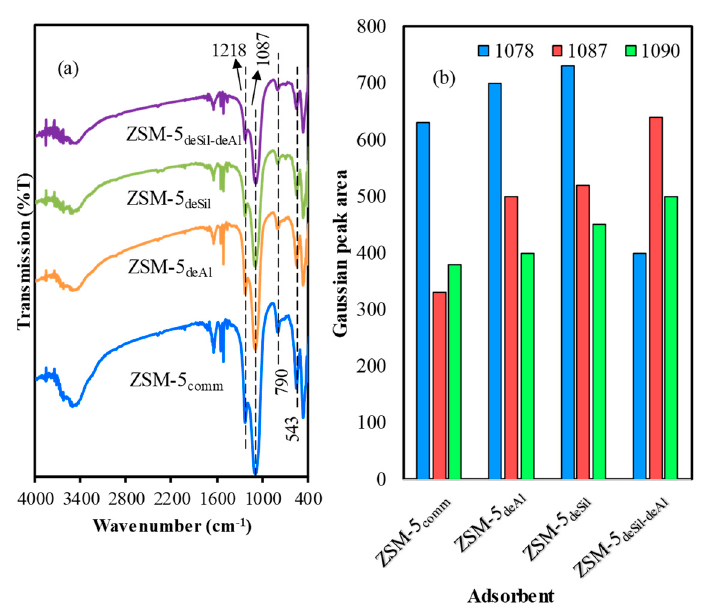
Figure 4. ( a ) FTIR results for all adsorbents ( b ) Gaussian peak area of 1087 cm − 1 .